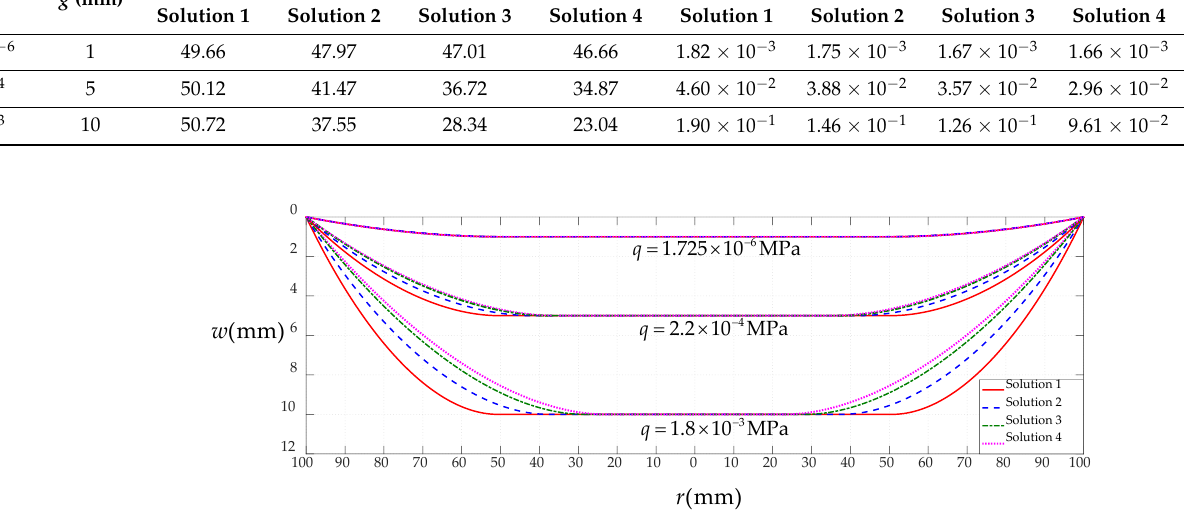
Table 5. The contact radius b and maximum stress σ m under different loads q .